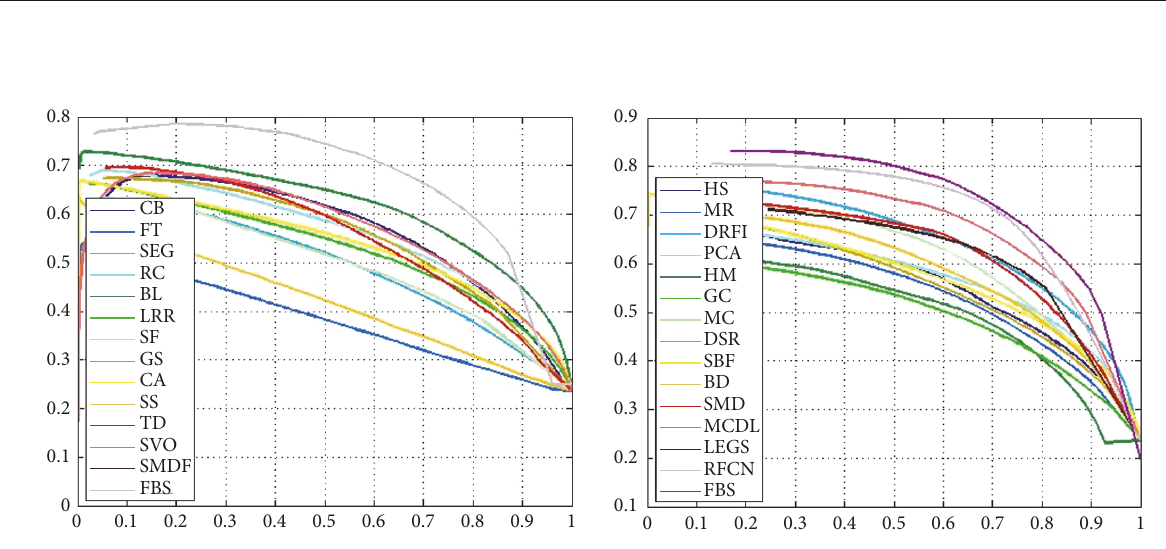
Figure 12: PR curves of FBS and 27 state-of-the-art methods.